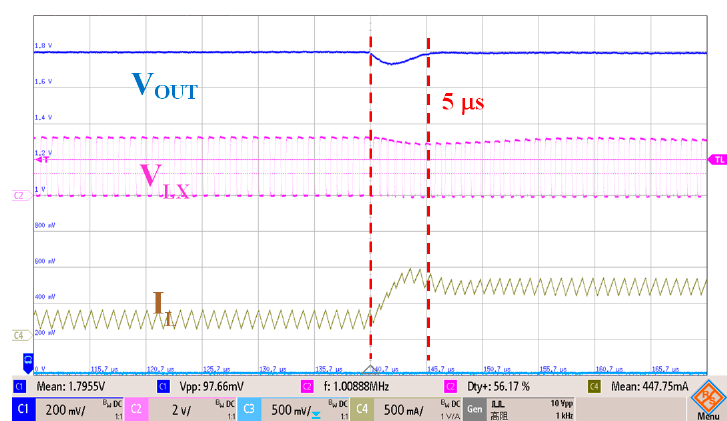
Figure 14. Measured transient response of the proposed DC-DC buck converter.